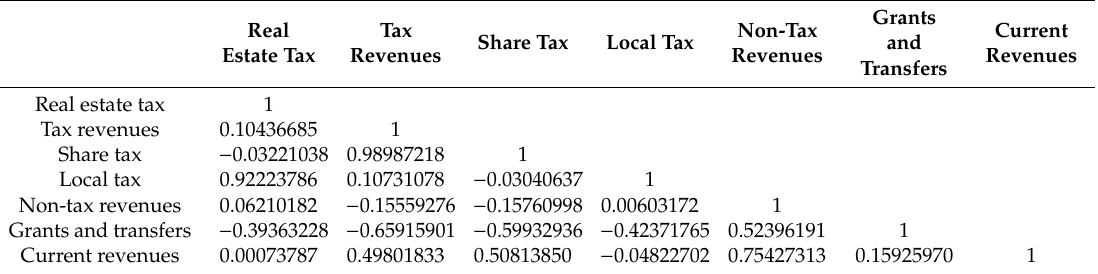
Table 5. Correlation analysis of individual components of current revenues of municipalities in